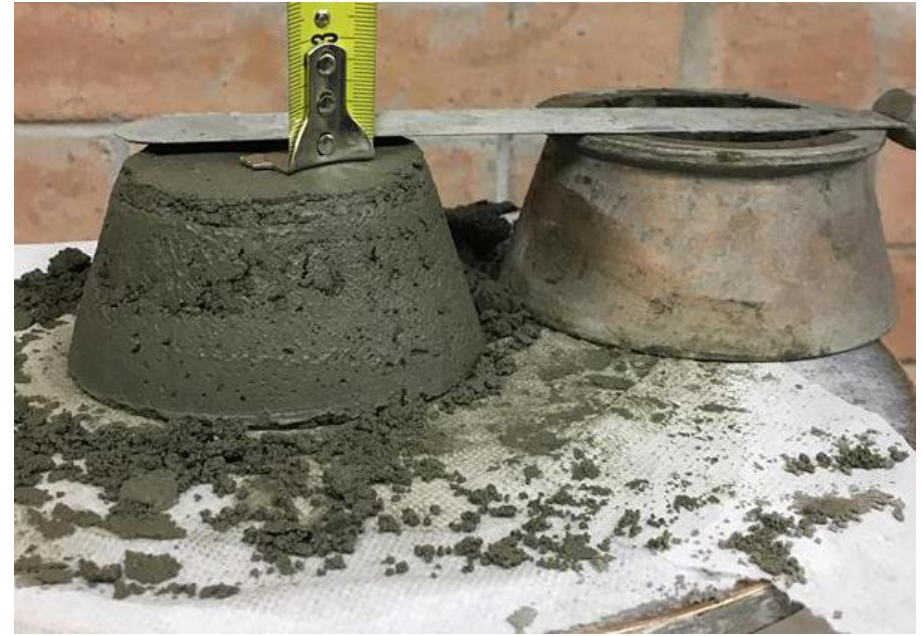
Figure 14. Mini-cone slump test for trial 8.